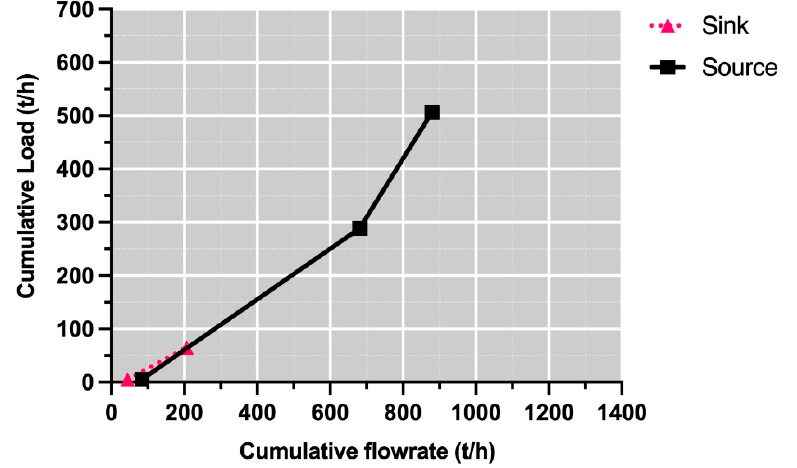
Figure 7. Composite curve for NaCl.